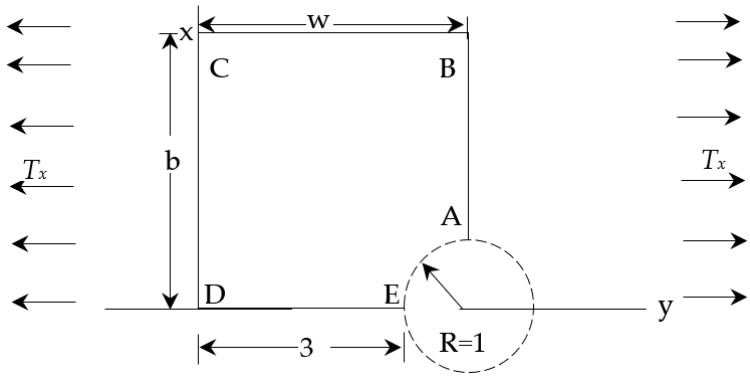
Figure 5. Plate with rigid circular opening. Table 8. Error properties found for LS- and RPI (MQ)-based recovery approach in incompressible- elastic analysis for plate with rigid circular opening considering influence zones and conventional patches. (Four-node quadrilateral equal elements).